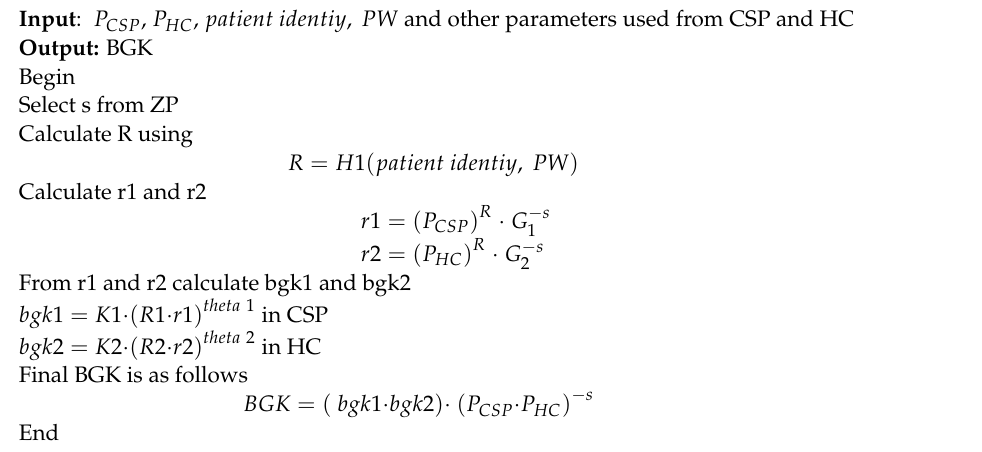
Algorithm 6: Break-Glass Key